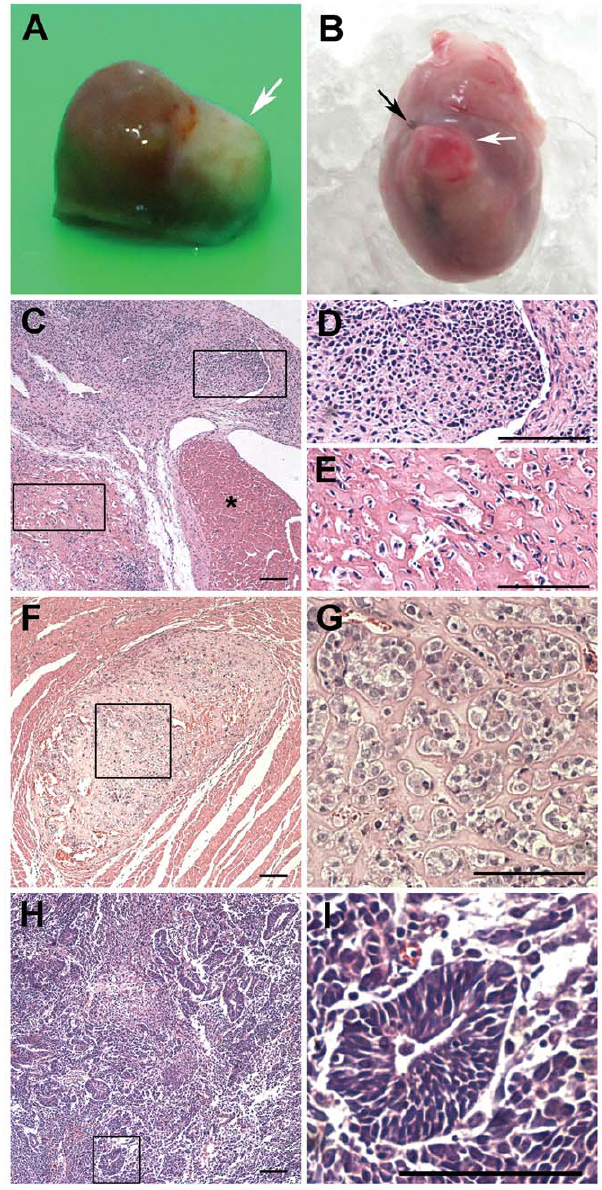
Figure 2. Transplantation of undifferentiated rat iPSCs causes tumorigenesis. A and B, Gross pathological evaluation revealed visible tumors (white arrows) extending from the left ventricular wall of the heart harvested 2 (A) or 6 (B) weeks after transplantation. The ligature site is indicated (black arrow) . C - I, Representative series of hematoxylin-eosin-stained sections from harvested tumors. C, Heart section from a myocardial infracted (MI) rat sacrificed 2 weeks after cell transplantation showed an undifferentiated cell graft, magnified in D , and osteogenic structures (mesoderm), magnified in E , in addition to normal cardiac tissue (*) . F, A clear-edged cartilaginous structure (mesoderm) within the cardiac tissue from an intact rat sacrificed 4 weeks after cell transplantation. G, High magnification of the inset in F. H, Neural rosettes (ectoderm) in a thoracic cavity tumor of an MI rat sacrificed 4 weeks after cell transplantation. A boxed rosette is magnified in I . Scale bars: 100 m m.